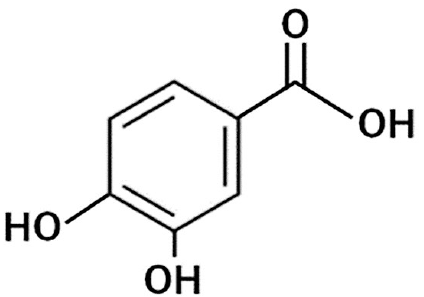
Figure 6. General structure of protocatechuic acid. Figure 6. General s tructure of protocatechuic acid.